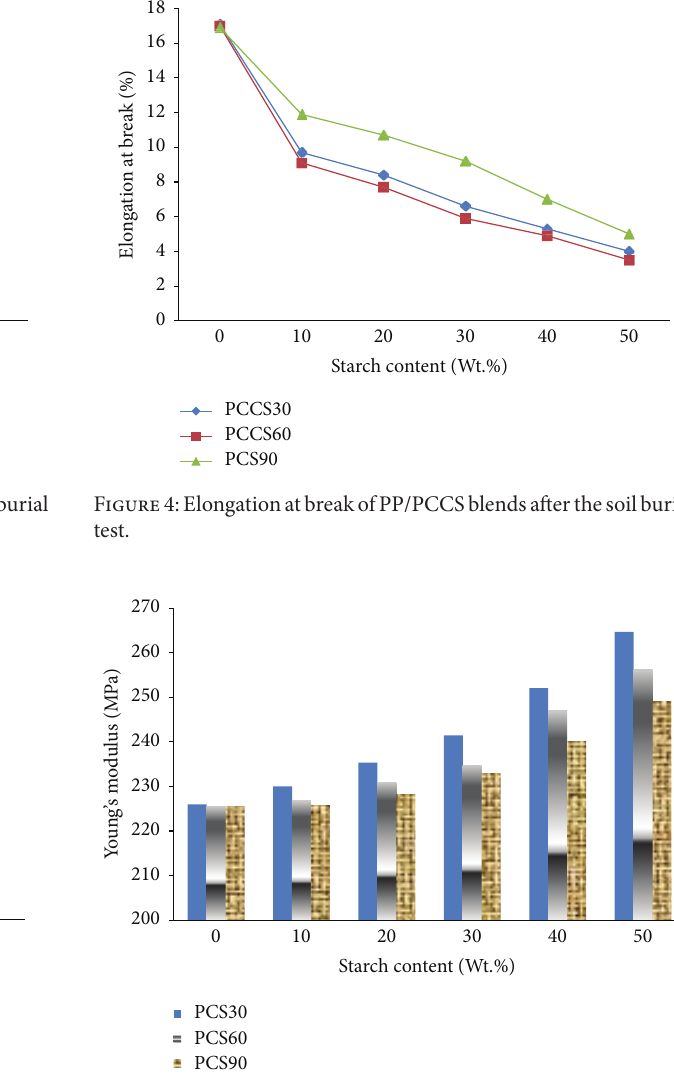
Figure 3: Elongation at break of PP/PCS blends after the soil burial test.